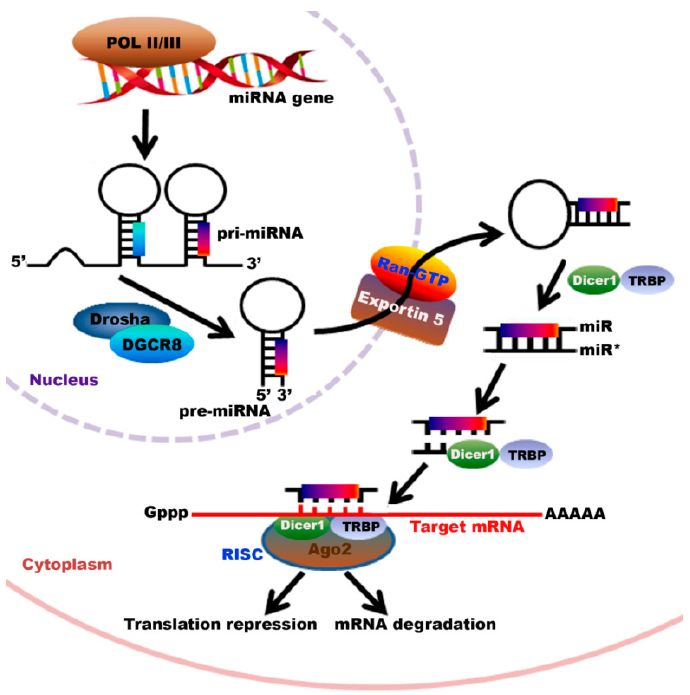
Figure 1. Biosynthesis of miRNAs. The miRNA is first transcribed within the nucleus by RNA polymerase II and II to generate a long primary miRNA (pri-miRNA), which is cropped by the Drosha/GDCR8 complex into precursor-miRNAs (pre-miRNAs). These pre-miRNAs are then transported to the cytoplasm through the interaction with nuclear transport receptor Exportin-5 and nuclear protein Ran-GTP. Once in the cytoplasm, the pre-miRNA is further processed by DICER1 and TAR-binding protein (TRBP) into a double stranded ~22 nucleotide product comprised of the mature miRNA guide strand and the miRNA* passenger strand. The miR* passenger strand is cleaved by Ago2 and the mature miRNA is then incorporated into the RNA-induced silencing complex (RISC) to target the 3 ′ -untranslated region of the target mRNA.